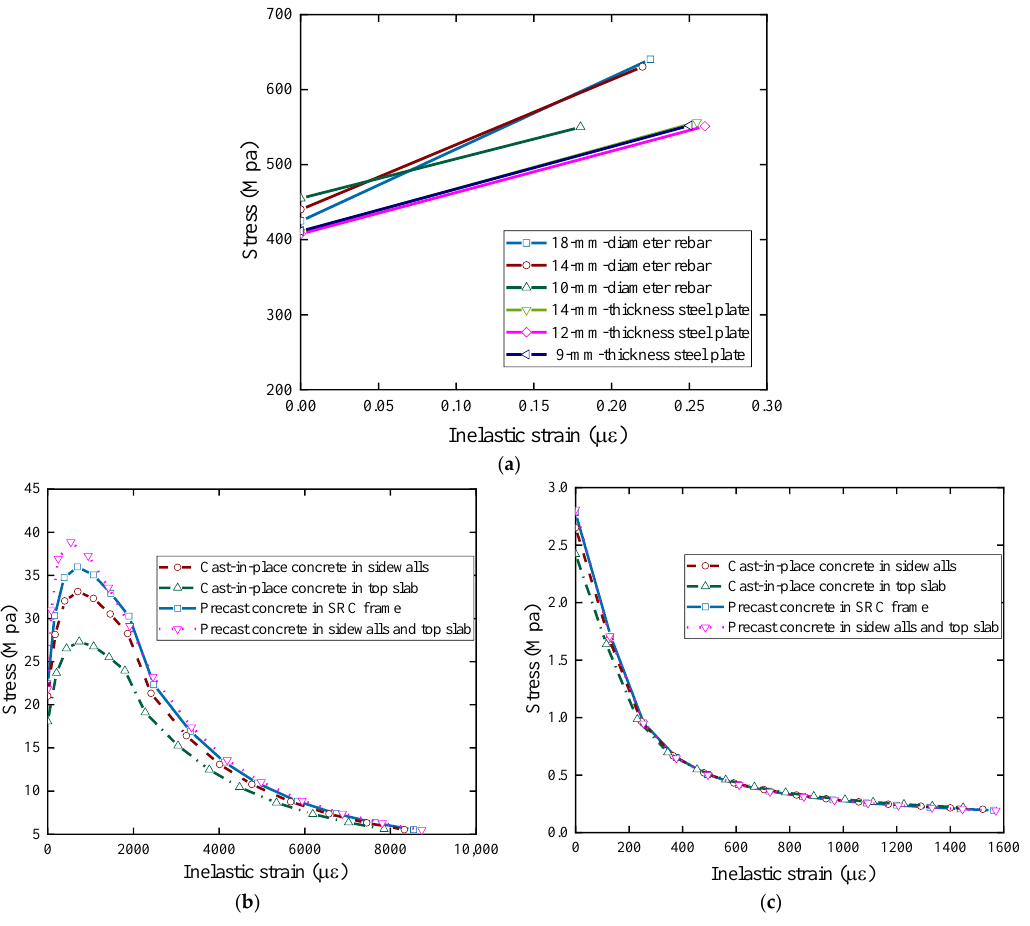
Figure 17. Stress–strain curves of steel and concrete: ( a ) steel constitutive curve, ( b ) concrete com- pressive stress–strain curve, and ( c ) concrete tensile stress–strain curve.